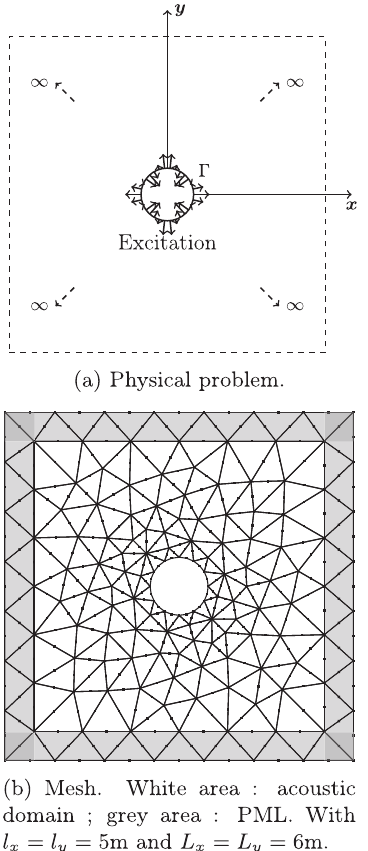
Figure 10. Pressure fi eld for n = 6 at 2000 Hz, 15 Gauss points per wavelength, C = 12.